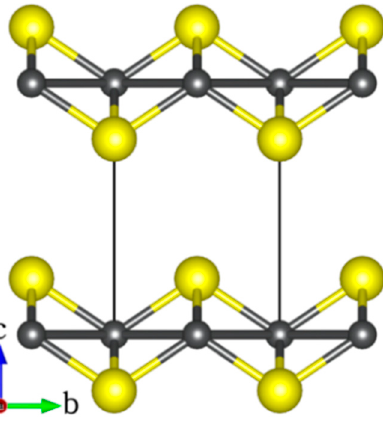
Figure 1. The layered tetragonal structure of FeS (atomic colour: Fe = grey, S = yellow). Displayed in Figure 2a is a (3 × 3) supercell of the perfect FeS (001) surface, showing that each iron atom is arranged in square ‐ planar coordination with neighbouring irons, and the sulfur atoms are in an asymmetric one ‐ sided four ‐ fold coordination with iron. A single (V S1 ) or double (V S2 ) sulfur vacancy on the FeS (001) surface was created by removing one or two surface sulfur atoms from the perfect FeS (001) surface, as shown in Figure 2 (b & c). We observe small contractions in the exposed square ‐ planar Fe–Fe distances in the defective (V S1 ) surface site, calculated at an average value of 2.466 Å compared to the 2.554 Å in the prefect stoichiometric (001) surface. For the V S2 surface, we observed both contraction and expansion in the exposed square ‐ planar Fe–Fe distances, with the shortest and longest Fe–Fe distances calculated at 2.379 and 2.731 Å, respectively.